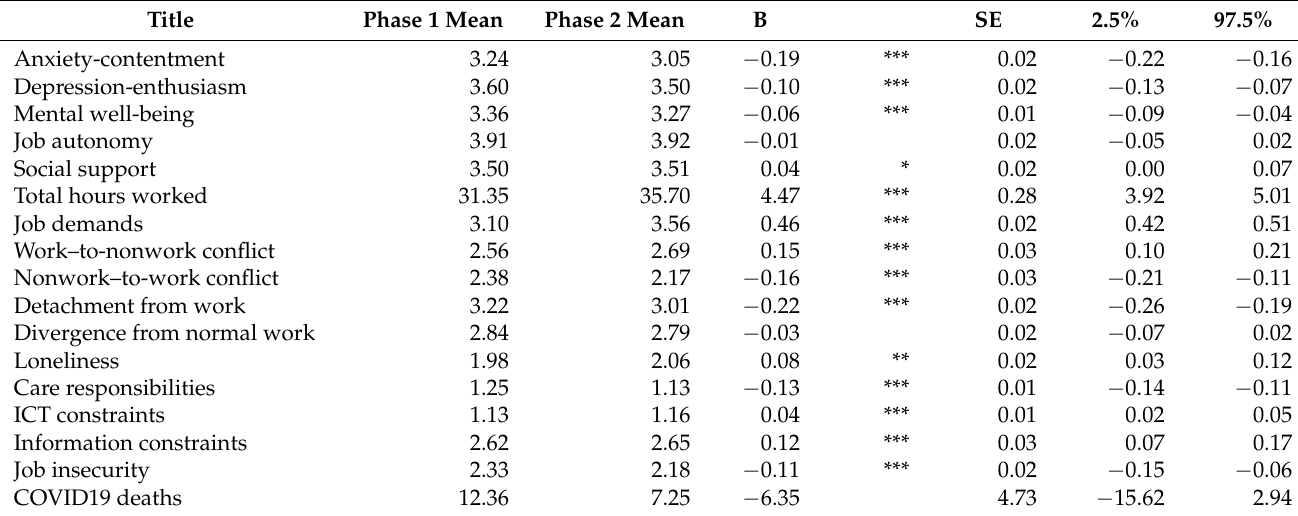
Table 9. Comparison of means between phase 1 and phase 2 for all